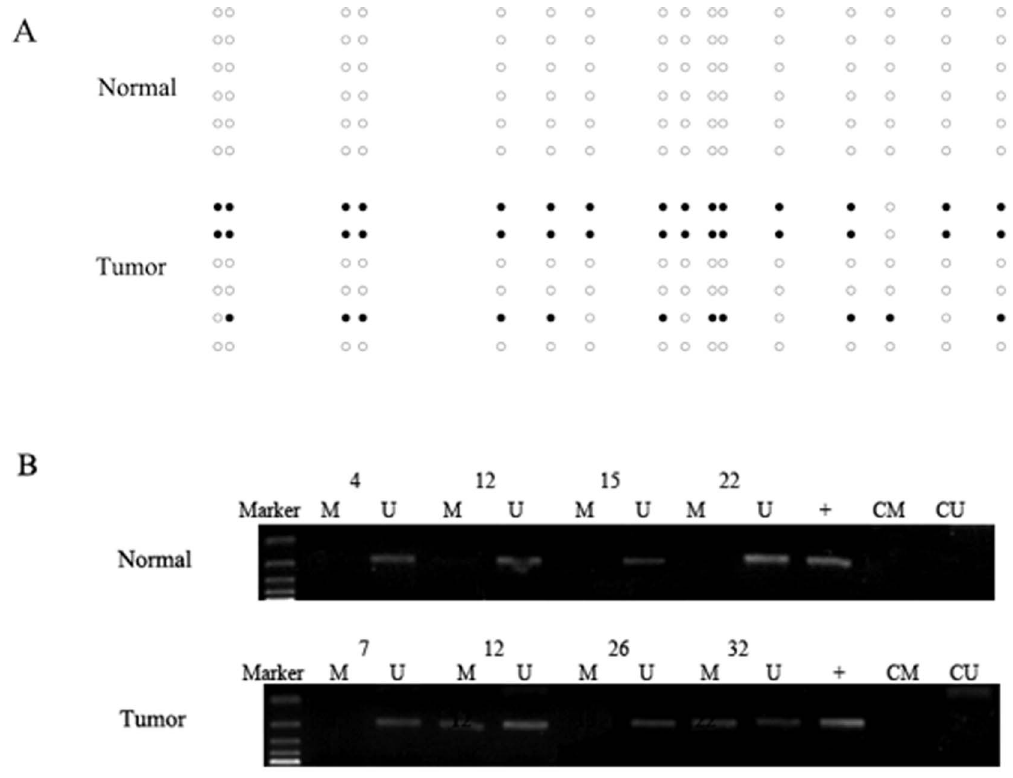
Figure 1. RASSF1A promoter methylation analyses in salivary adenoid cystic carcinoma and normal salivary gland tissues. A. RASSF1A promoter methylation in case 4 was detected by bisulfite sequencing. Each circle indicates a CpG dinucleotide and each row indicates the sequencing result of one clone. Black and white dots indicate methylation and unmethylation of a CpG dinucleotide, respectively. There was no RASSF1A promoter methylation in normal tissue and partial promoter methylation in tumor tissue in case 4. B. MSP analysis of the promoter methylation status of RASSF1A in normal and tumor tissues. M indicates DNA amplified with methylation-specific primers; U, DNA amplified with unmethylation-specific primers; + , positive control; CM, blank control for methylation; CU, blank control for unmethylation.